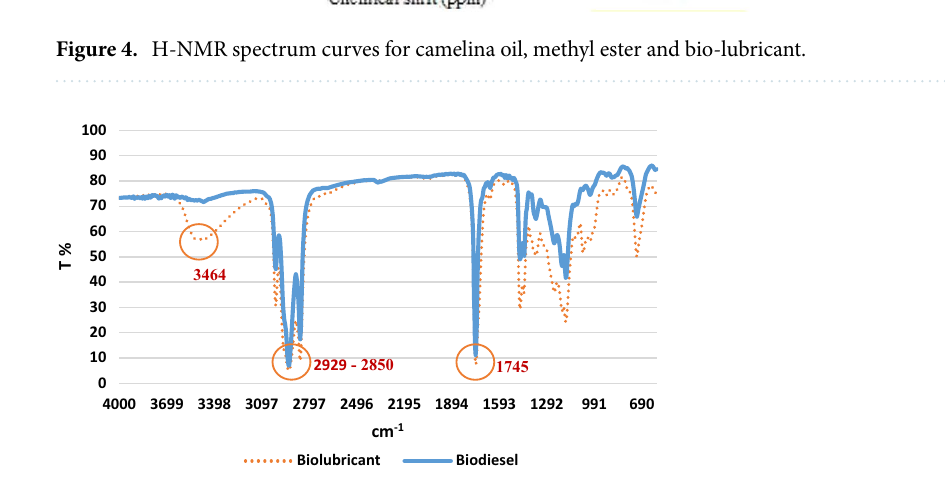
Figure 5. FTIR spectrum curves for methyl ester and bio-lubricant derived from camelina